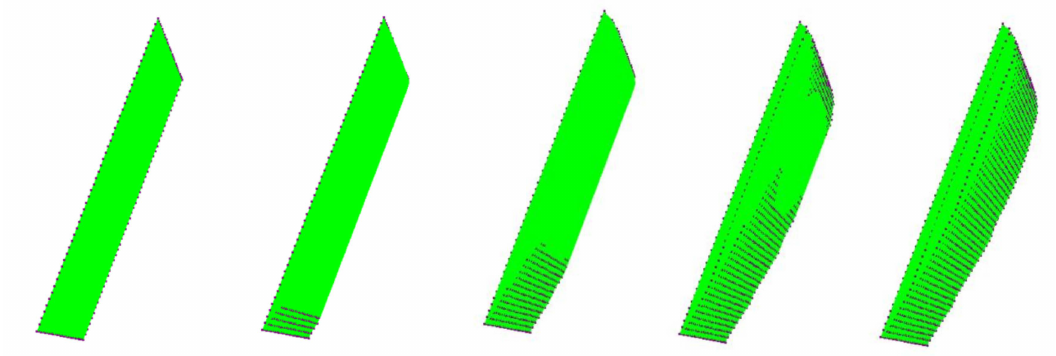
Figure 8. Evolution of the distribution of the contact nodes with the mold at the beginning, middle, and the end of the forming cycle.